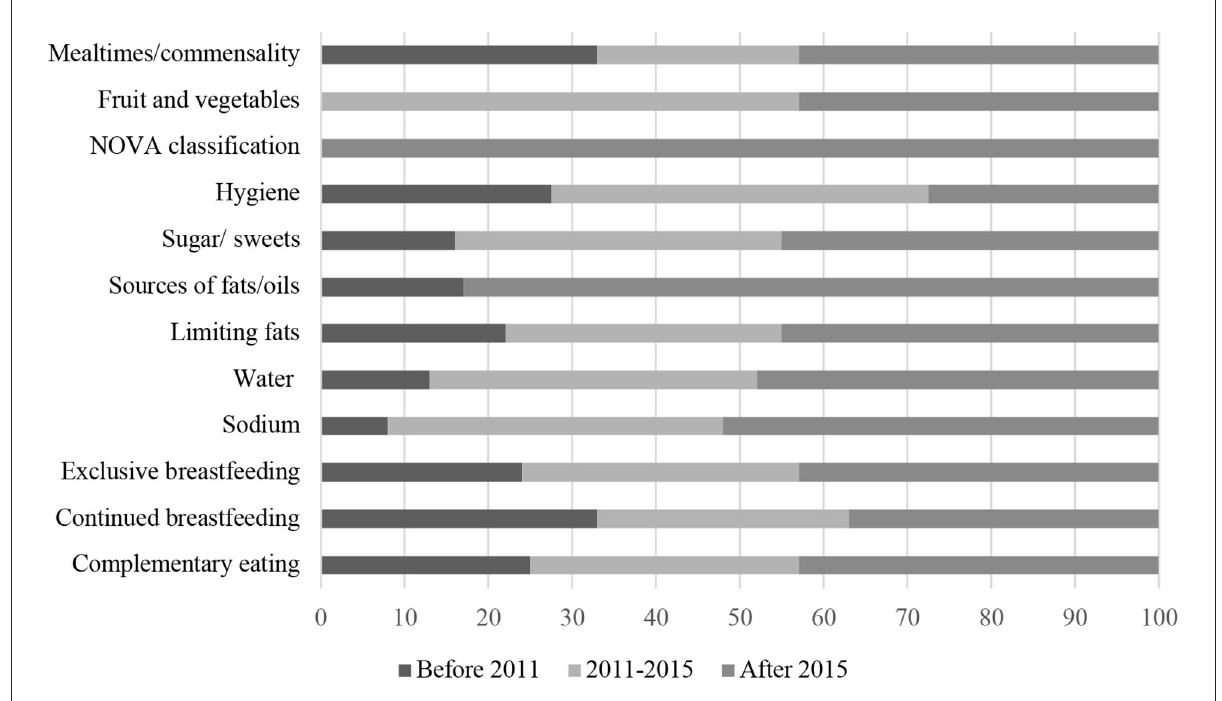
FIGURE5 Percentage distribution of FGDBs with specific nutritional recommendations according to the year of publication.